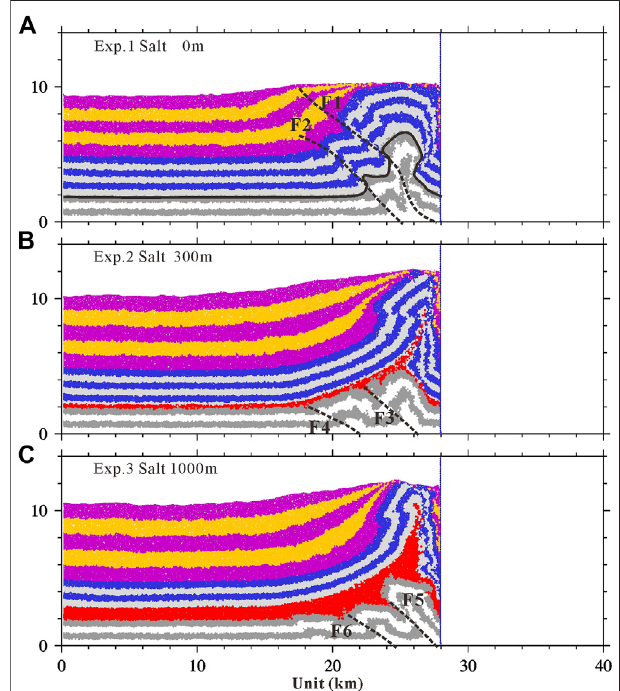
FIGURE 5 | Final deformations of three shortening experiments with differentsaltthicknessesafter12 kmofshortening. (A) Referenceexperiment. (B) Experiment with thin salt (ca. 300 m). (C) Experiment with thick salt (ca. 1,000 m). White and gray denote the subsalt layer. Red denotes the salt layer. Blue and gray denote the prekinematic layer. Violet and yellow denote the synkinematic layer. Bonds of assigned strengths ( Table 2 ) were introduced at all interparticle contacts, except the synkinematic layer (violet and yellow)and salt layer (red). Dashed lines denote faults. The fi gures ofeach step are included in the Supplementary Material